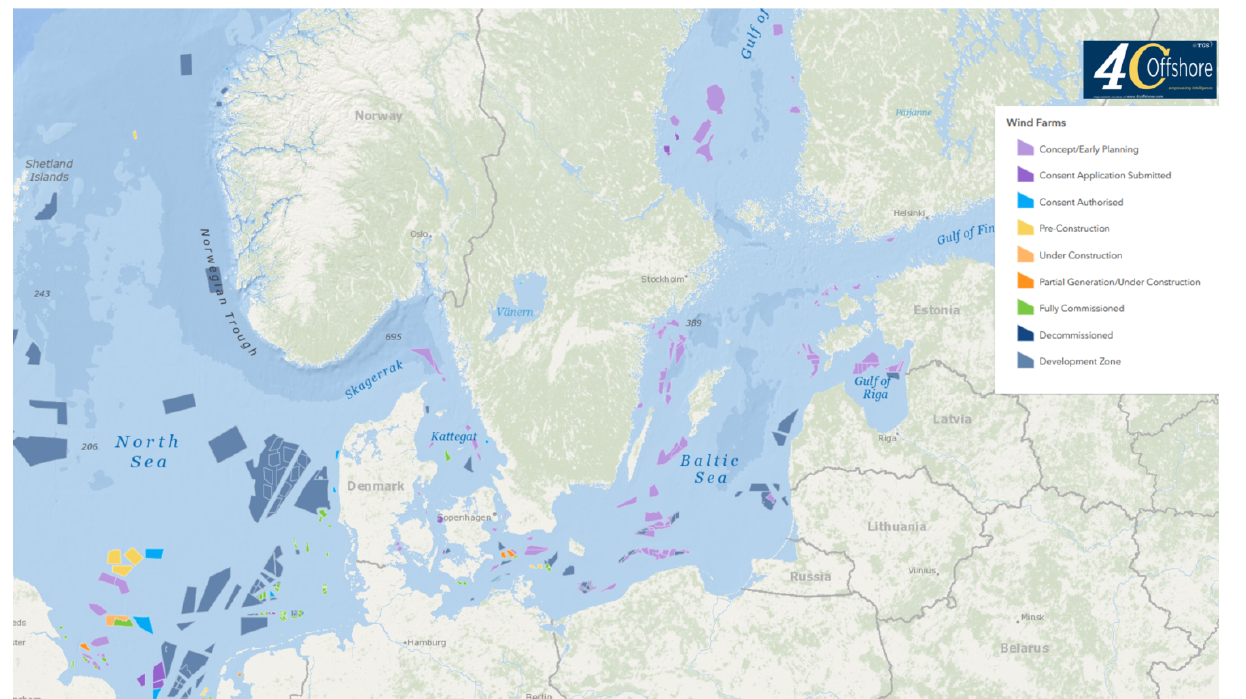
Figure 2. Offshore wind farms in the Baltic Sea (https://www.4coffshore.com/offshorewind/, last access: 10 December 2021), as of 24 June 2021, courtesy of